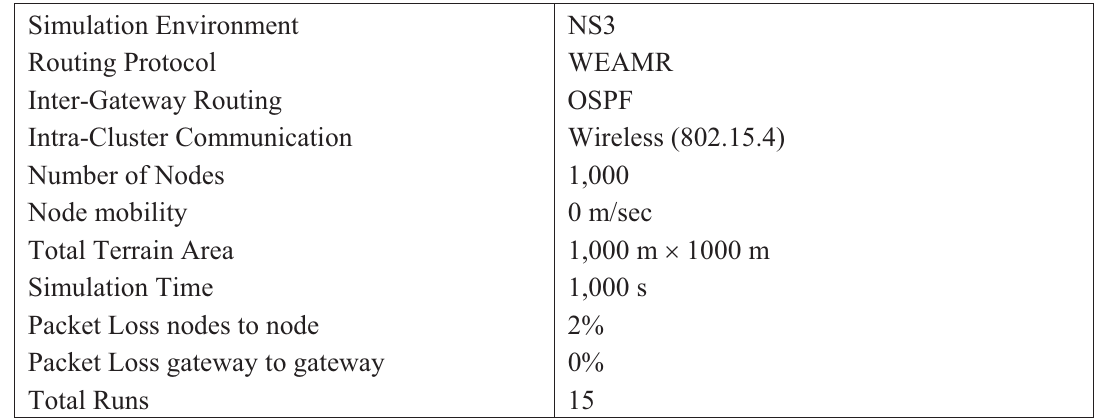
Table 1. Simulation